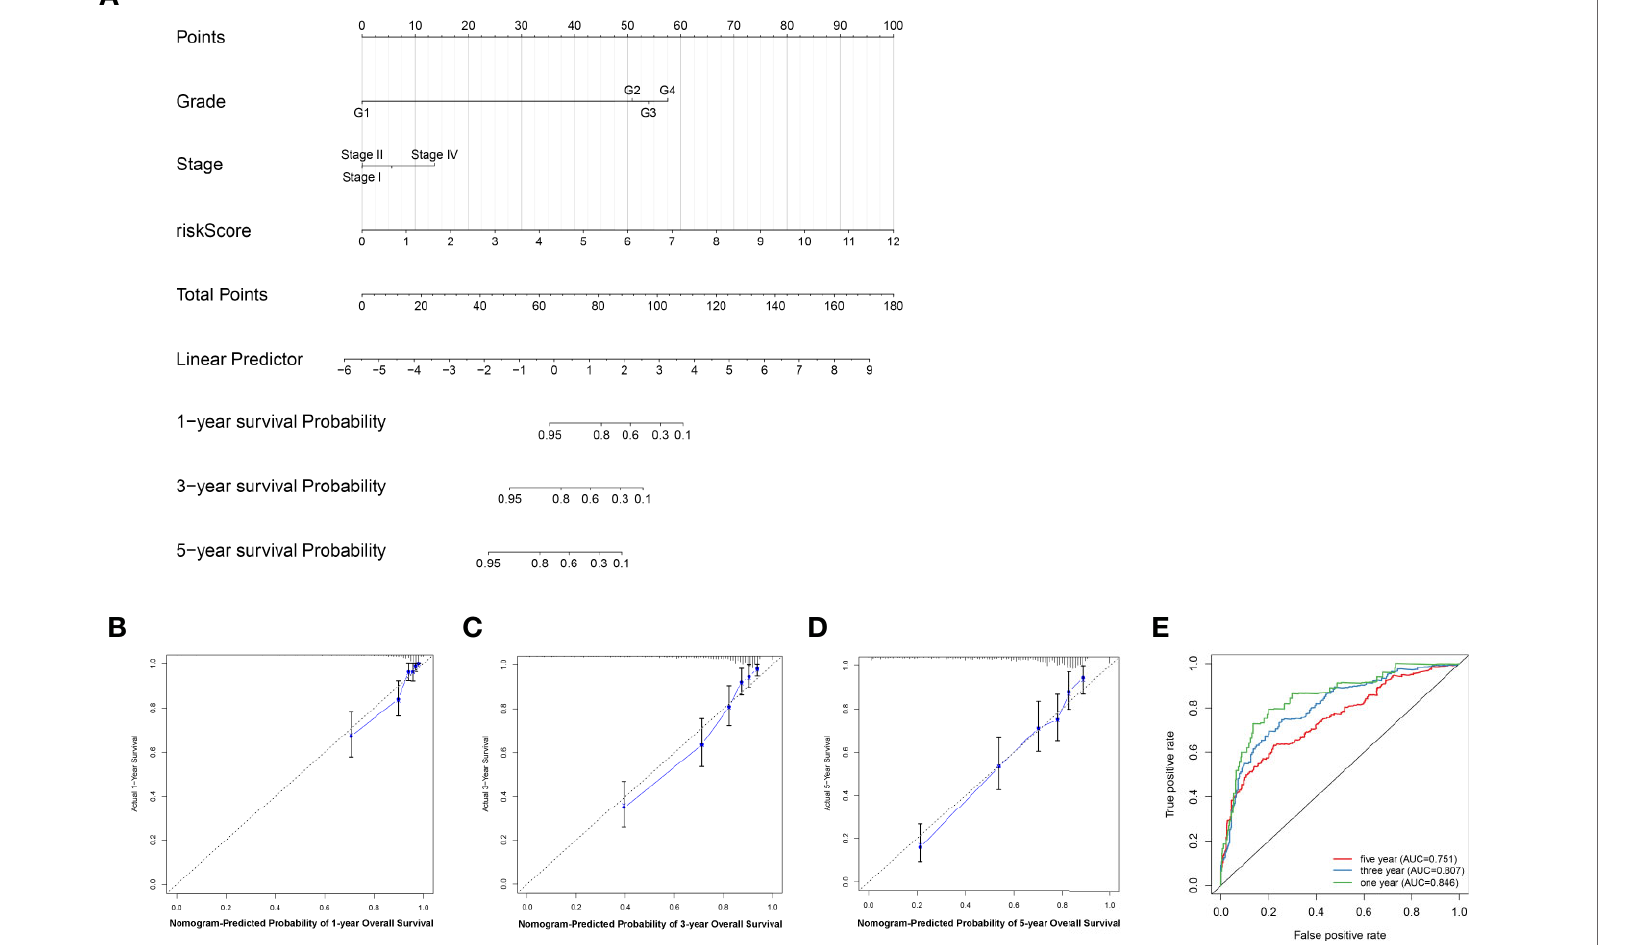
FIGURE 7 | An individualized prediction model for overall survival (OS) of patients with ccRCC. (A) Nomogram construction for the 1-, 3- and 5- year OS prediction for the ccRCC. (B – D) Calibration curves analysis of the nomogram for predicting 1-, 3- and 5-year OS in the TCGA dataset. (E) Evaluation of the accuracy of the nomogram in 1-, 3- and 5-year by using the ROC